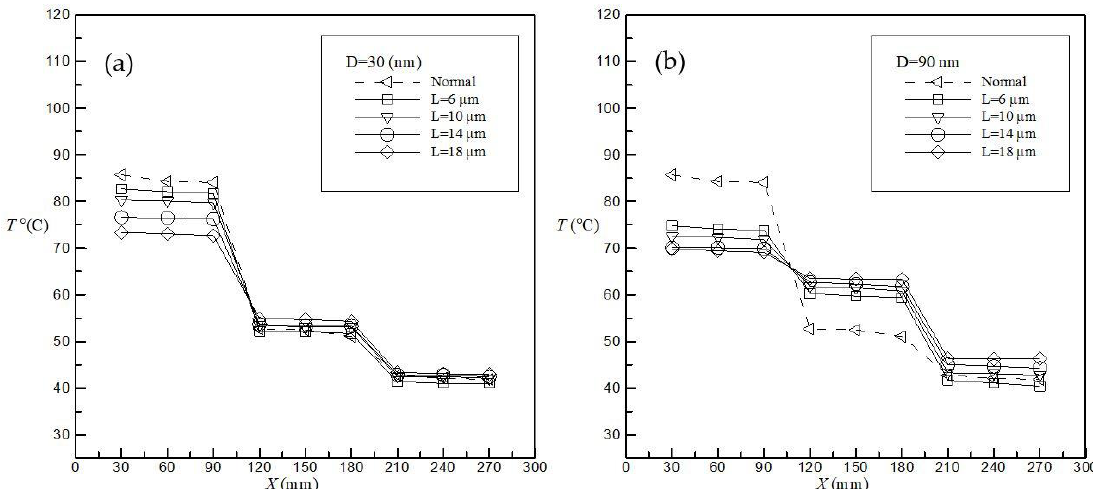
Figure 6. Temperature distribution along heat pipe at Q in = 100 W for different values of the tube length L with: ( a ) D = 30 nm; and ( b ) D = 90